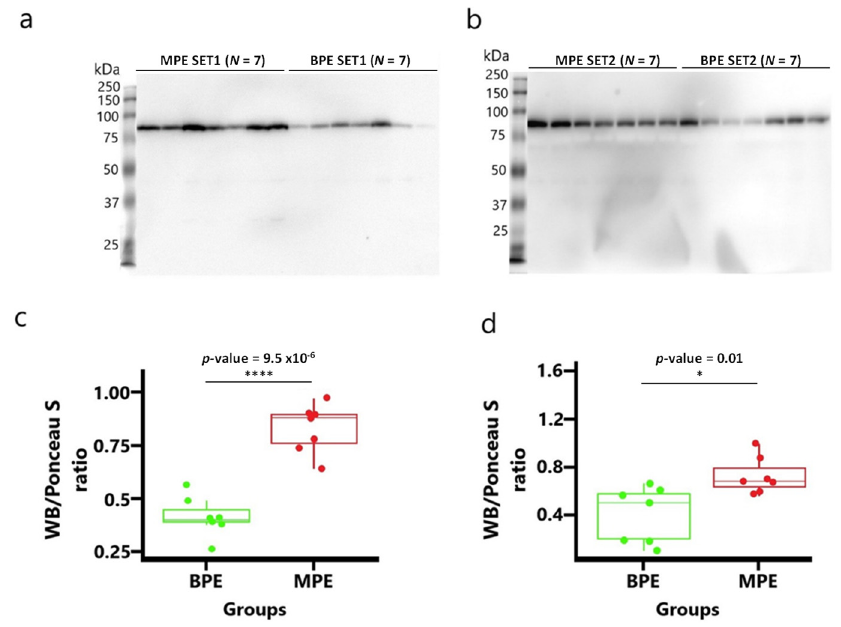
Figure A6. Western blot analysis showing expression of Afamin (AFM) in PE samples corresponding to the molecular size of ~87 kDa ( a , b ). Quantification of the Western blot bands was normalized with Ponceau S staining of the same membranes and the ratio of Western blot bands to Ponceau S experiment was shown in ( c , d ). * indicates p -value = 0.01.**** indicates p -value < 0.0001.